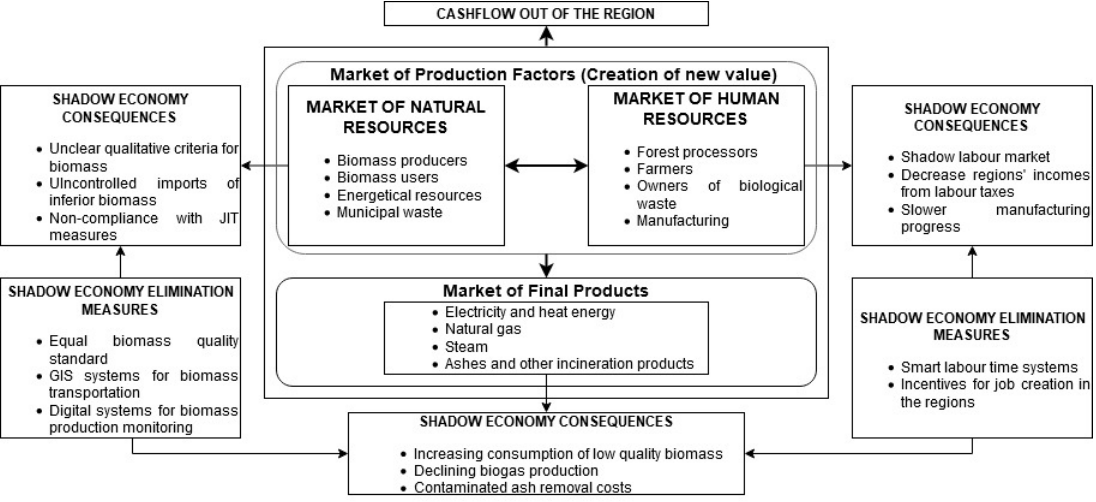
Figure 2. Impact of the shadow economy on the energy sector of Lithuanian regions.